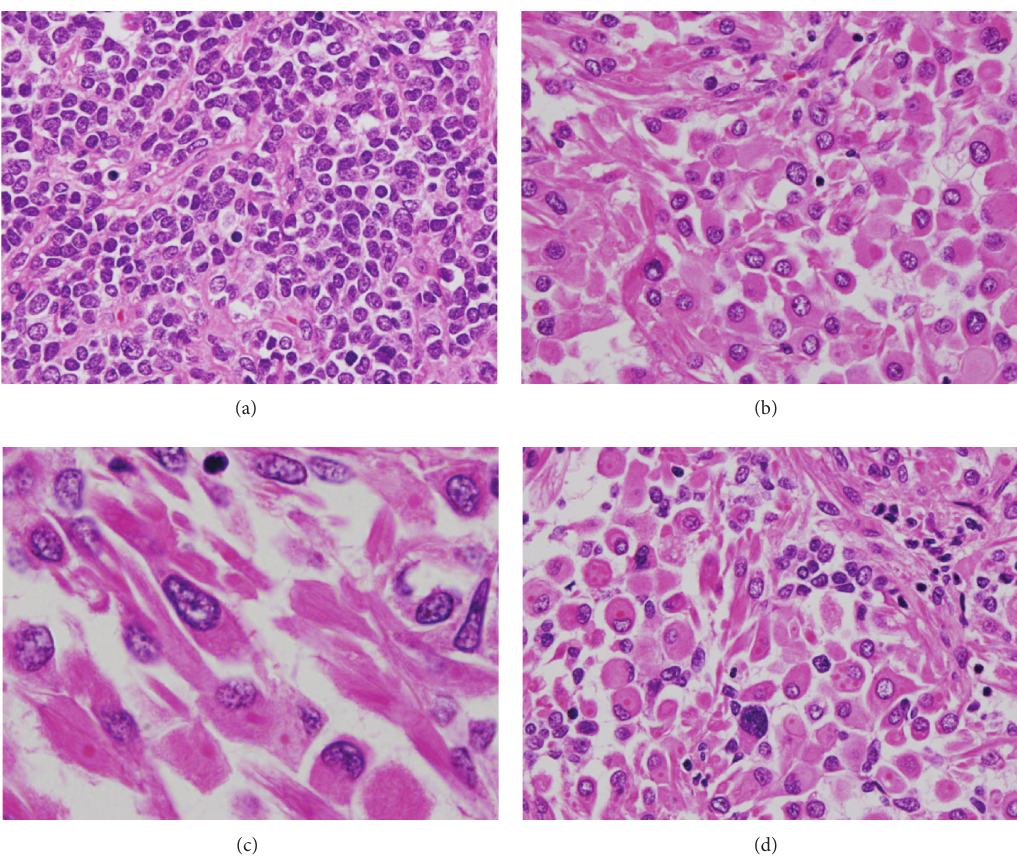
Figure 2: Microscopic findings. (a) Component A showed small round cell proliferation. (b) Component B consisted of large, round- to-polyhedral cells with abundant eosinophilic cytoplasm. (c) Cross-striation was observed in these cells. (d) Cells of two components intermingled intimately (H&E original magnification × 40 for (a), (b), and (d) and × 100 for